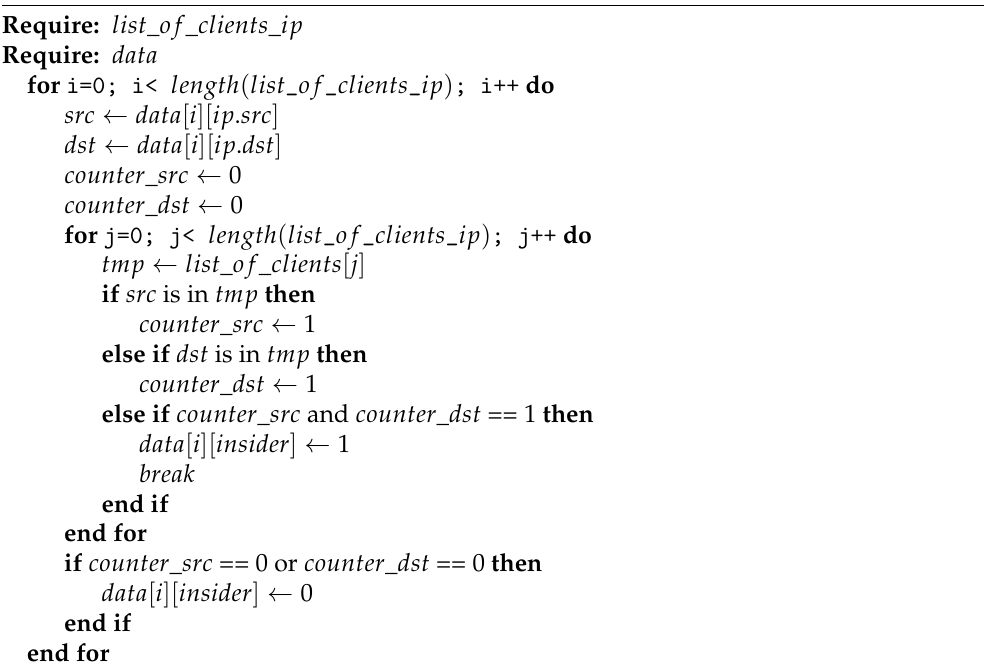
Algorithm 1 Algorithm for constructing the “Insider” feature.